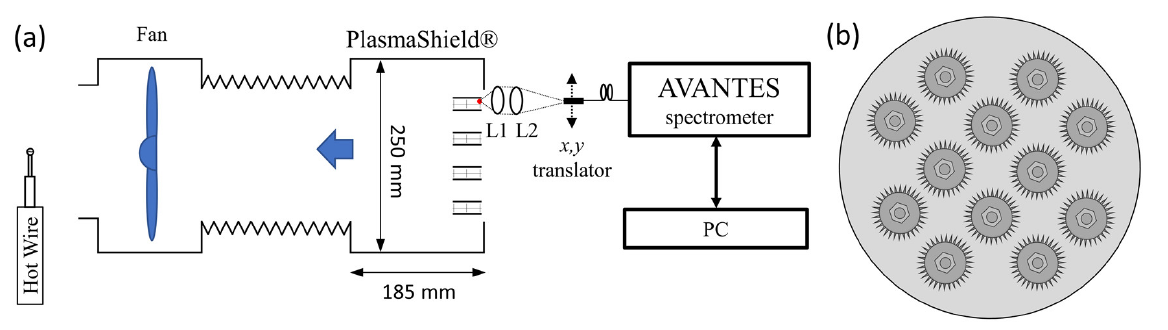
Figure 1. ( a ) Experimental set-up for PlasmaShield ® Air Purification Device (PSAPD) and optical emission spectroscopy. A fiber optic cable was mounted on a mechanical translation stage to enable spatial-resolved scanning. L1 and L2: fused silica lenses. ( b ) The front illustration of the system.